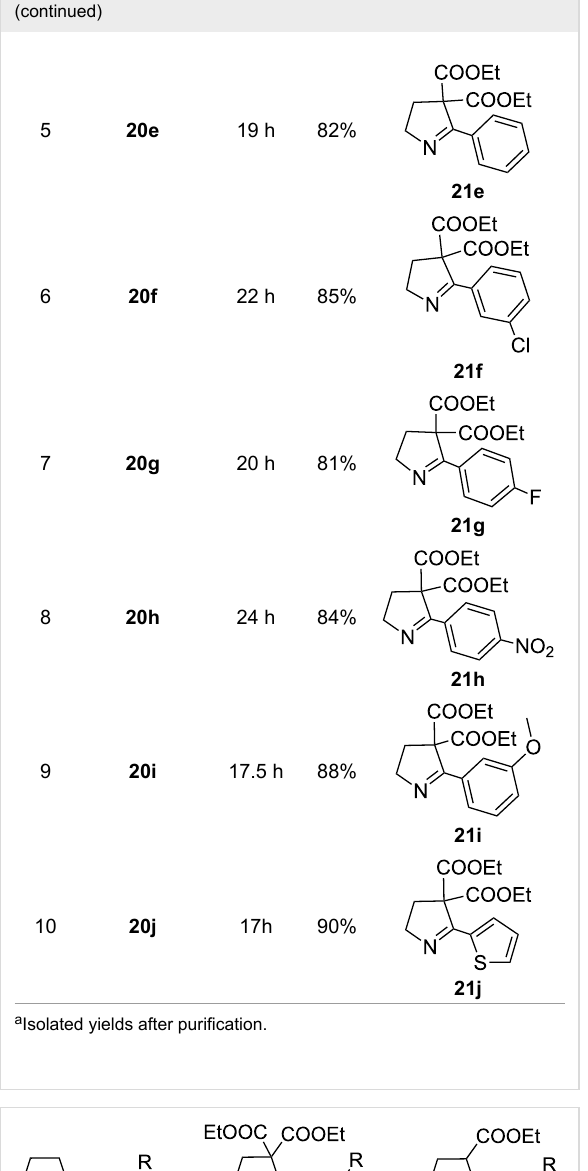
Table 2: Iodide ion mediated ring expansion of N -vinylaziridines.